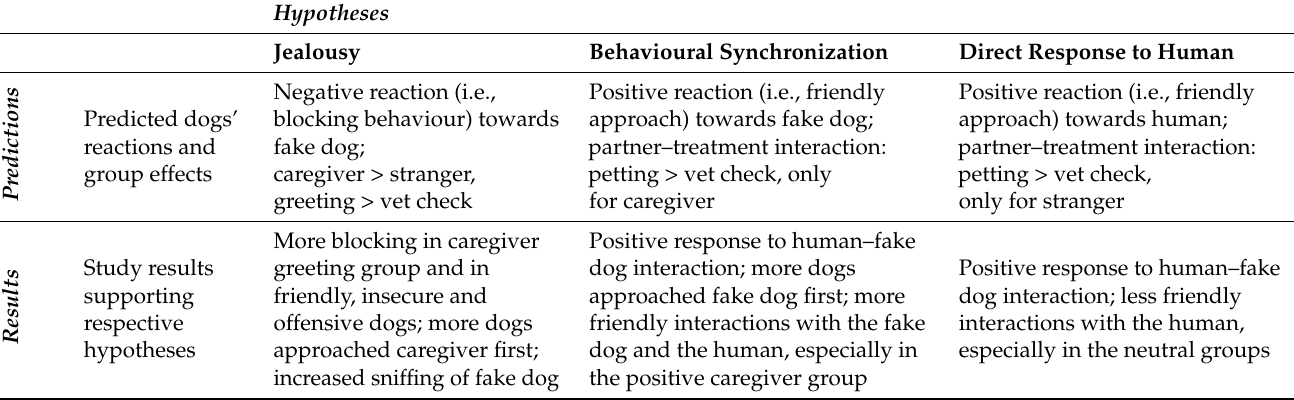
Table 4. Overview of the hypotheses, predictions, dependent variables and the results supporting each